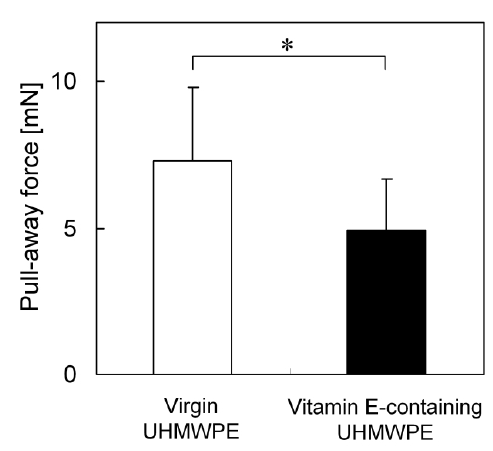
Fig. 7 Pull-away force between UHMWPE and the Co-28Cr-6Mo alloy. Data represent mean±SD. Asterisk indicates a statistically significant difference (*; P<0.05, n=8, by student’s